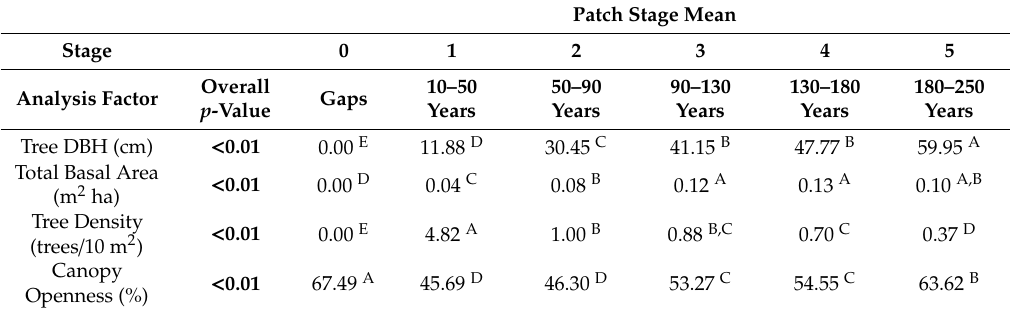
Table A2. Mean values of different soil attributes in each of the six patch stages and overall stage effect p -value from PerMANOVA analyses. Bold p -values indicate significant results ( p < 0.05) and shared letter subscripts denote non-significant differences indicated by PerMANOVA pairwise comparisons.